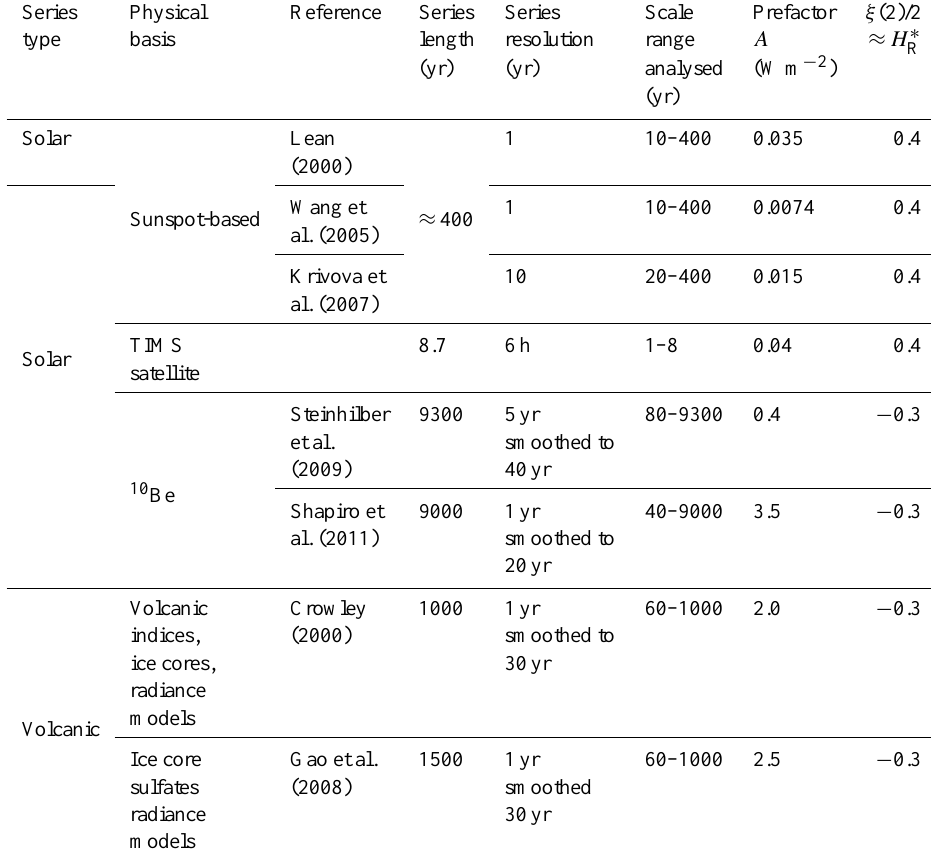
Table 4. A comparison of various climate radiative forcings ( R F ) discussed in Lovejoy and Schertzer (2012c), estimated over the length of time indicated in the fourth column up to the present (Fig. 9 shows industrial and preindustrial analyses for selected series). The exponents were estimated to the nearest 0.1 and the prefactors A are for the formula h (1R F ) 2 i 1 / 2 = A1t ξ( 2 )/ 2 with 1t expressed in